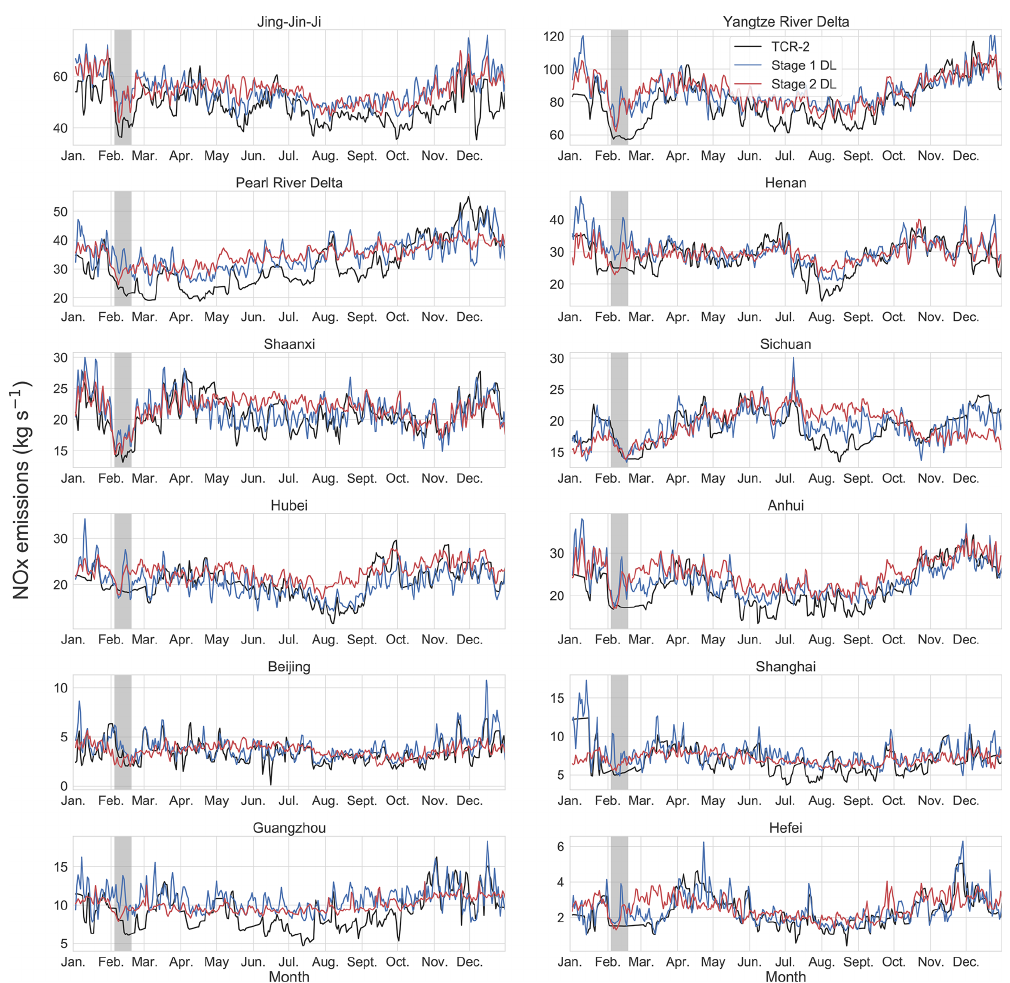
Figure 6. Time series of daily mean NO x emissions in 2019 for three Chinese metropolitan regions (Jing-Jin-Ji, the Yangtze River Delta, and the Pearl River Delta), five selected provinces (Henan, Shaanxi, Sichuan, Hubei, and Anhui), and four major cities (Beijing, Shanghai, Guangzhou, and Hefei) for 2019 (the testing period). Shown are the emissions from the TCR-2 estimates (black) and the DL analysis after Stage 1 (blue) and Stage 2 (red). The shaded areas represent the 14d period after the Chinese New